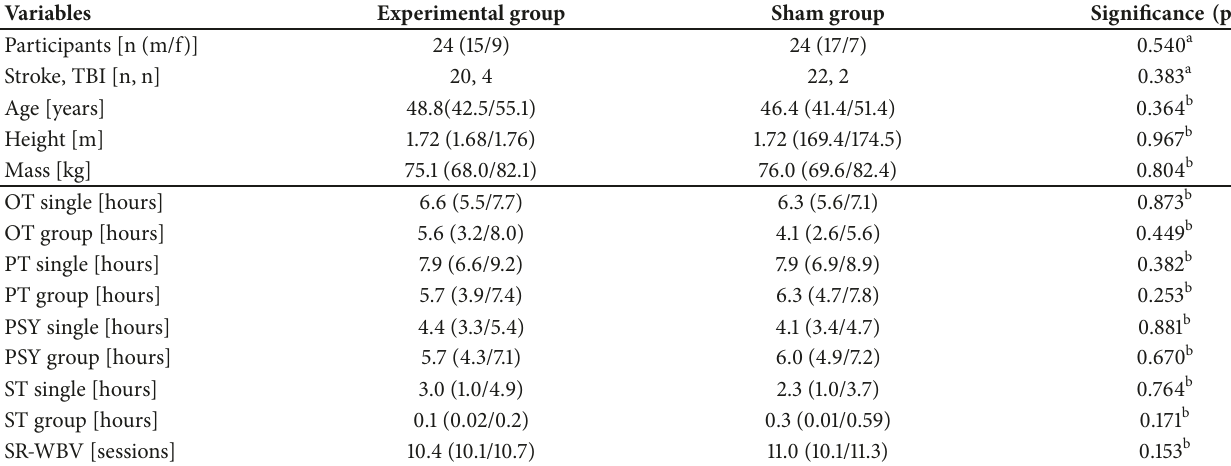
Table 1: Demographics of the individuals with stroke and traumatic brain injury (TBI), therapy characteristics [n, arithmetic mean (lower/upper limit 95% confidence interval), and significance test] at baseline (pre) and amount of completed complementary SR-WBV sessions at discharge (post